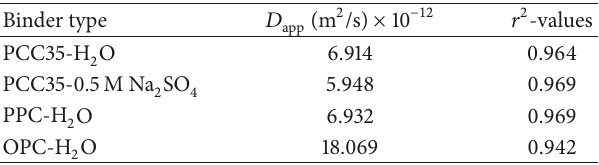
and 𝑟 2 -values for different cement mortars at 𝑤/𝑐 =